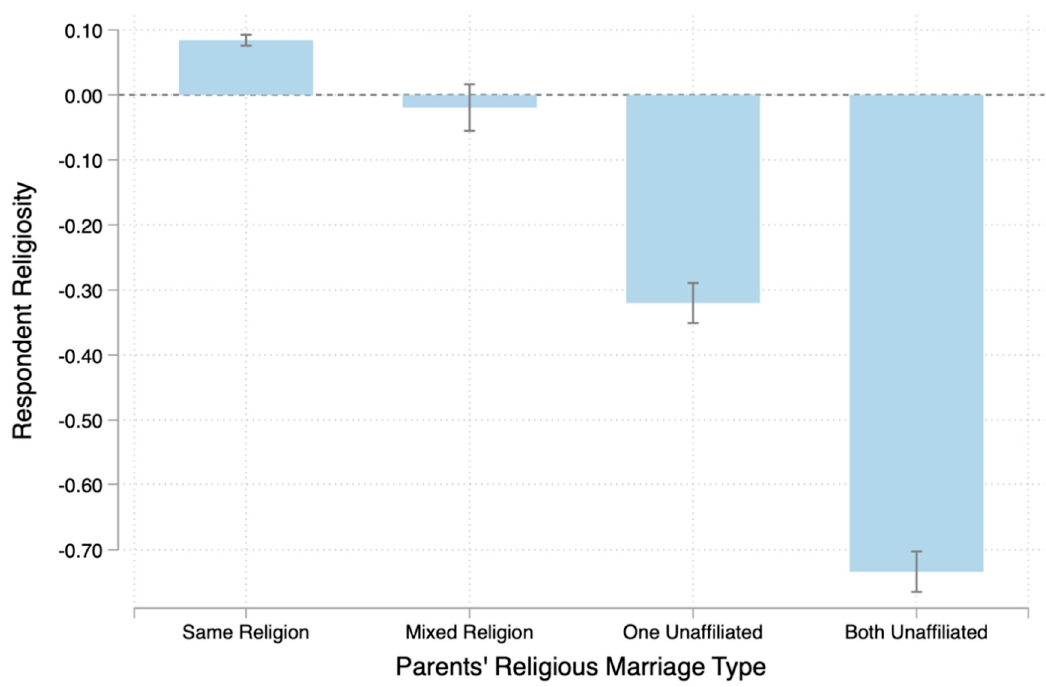
Figure 3. Predicted values of respondent religiosity by parents’ religious affiliation combination. Values less than 0 indicate below-average respondent religiosity.